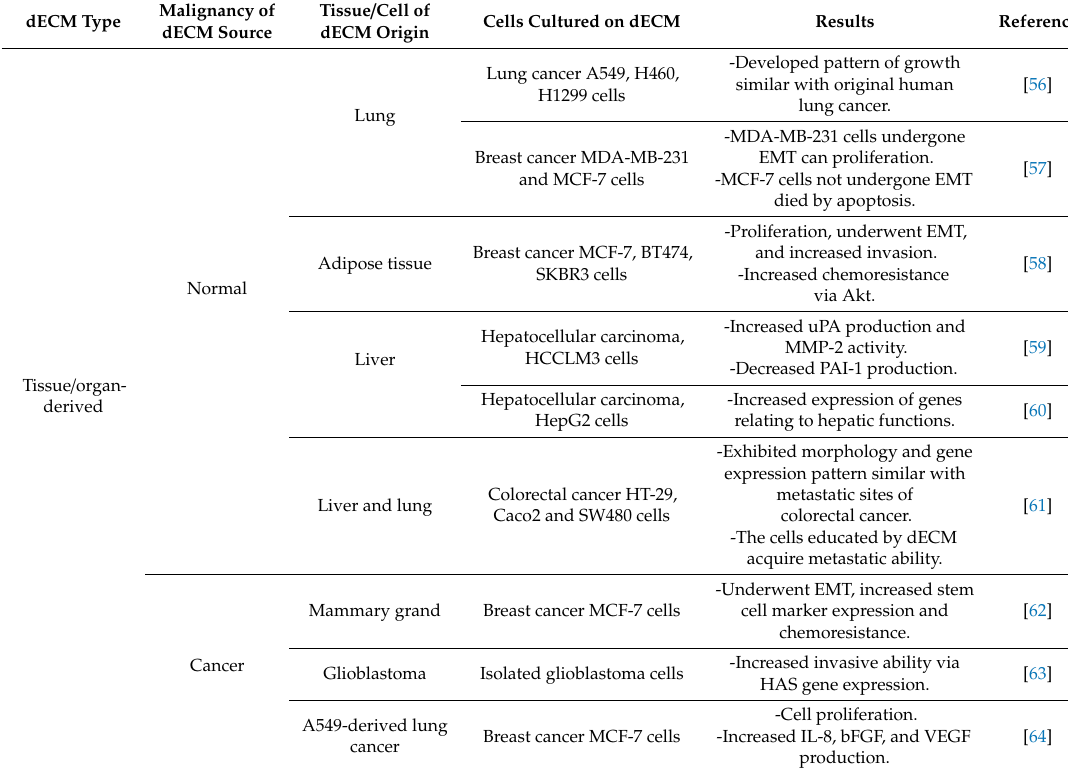
Table 3. Partial list of dECM utilized for cancer